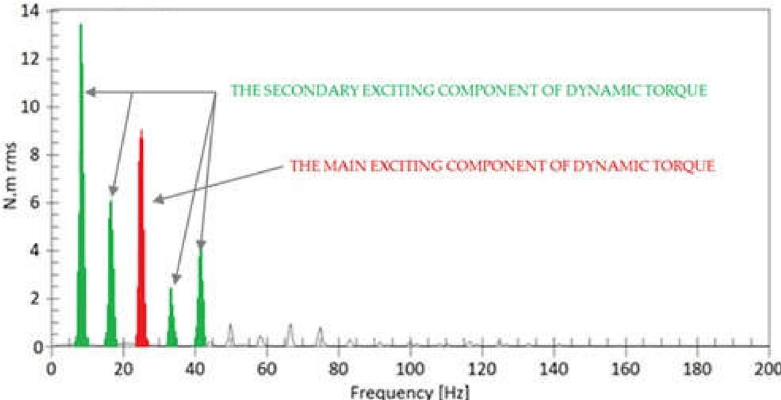
Figure 7. Frequency amplitude spectrum with deactivation of one cylinder in the compressor.